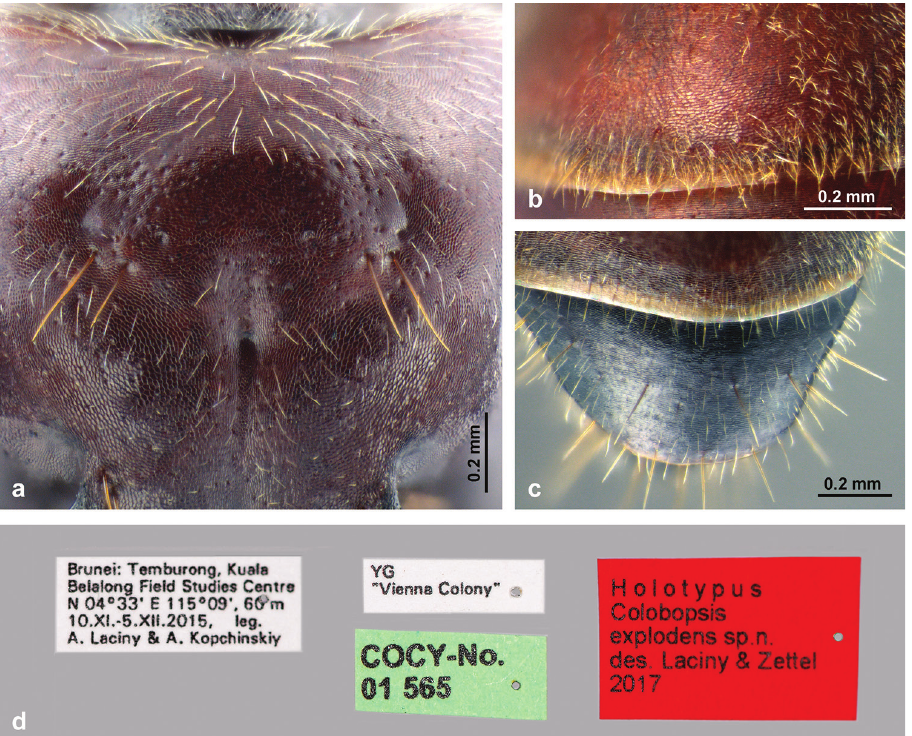
Figure 4. Cuticular microsculpture of C. explodens sp. n.; a vertex of major worker (paratype) b gastral tergite I, and c gastral tergite IV of minor worker (holotype) d labels of holotype, minor